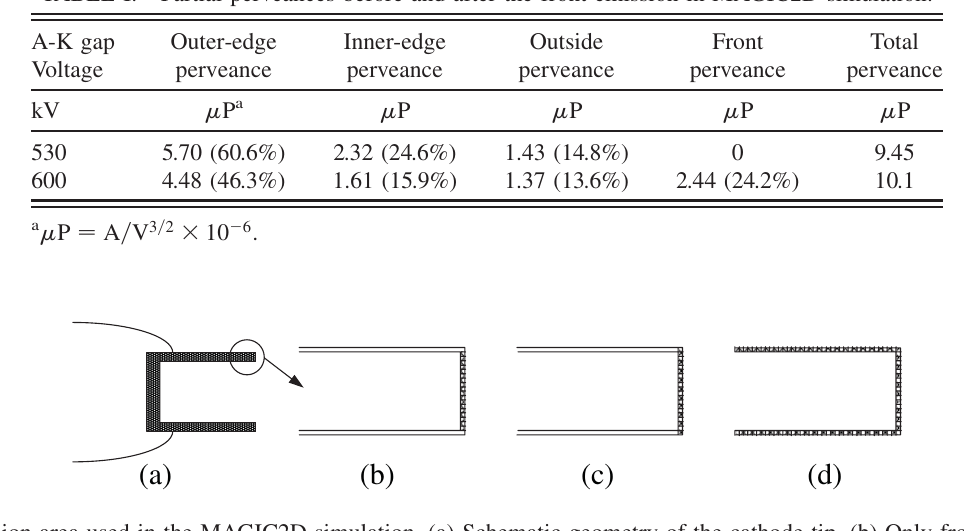
FIG. 9. Emission area used in the MAGIC2D simulation. (a) Schematic geometry of the cathode tip. (b) Only front emission was allowed. (c) Both front and edge emissions were allowed. (d) All front, edge, and side emissions were